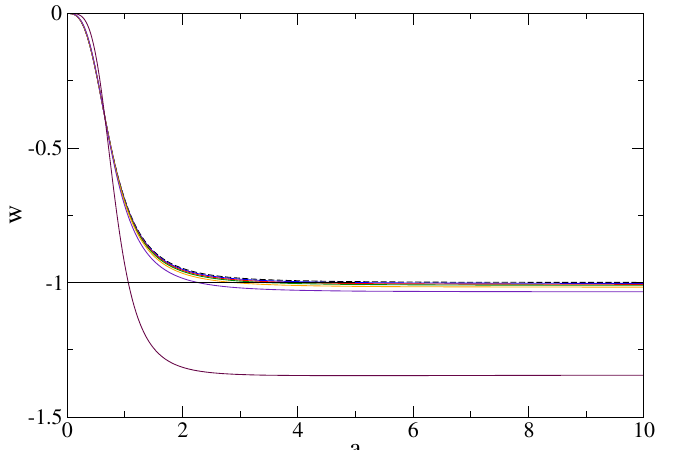
Figure 4. EoS parameter w as a function the scale factor a for Ω m ,0 = 0.309, B = 3.53 × 10 − 3 and n =